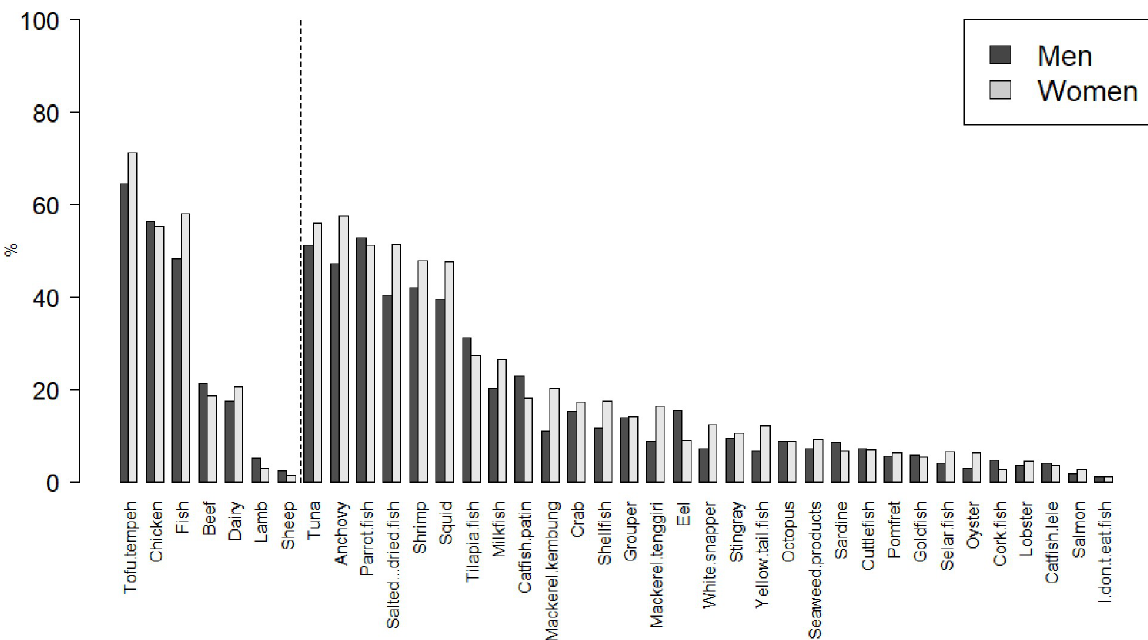
Fig 4. Gender ratios of protein types consumed per week (left) and seafood products consumed per year (right), sorted by the percentage of respondents in the sample population for the whole province.